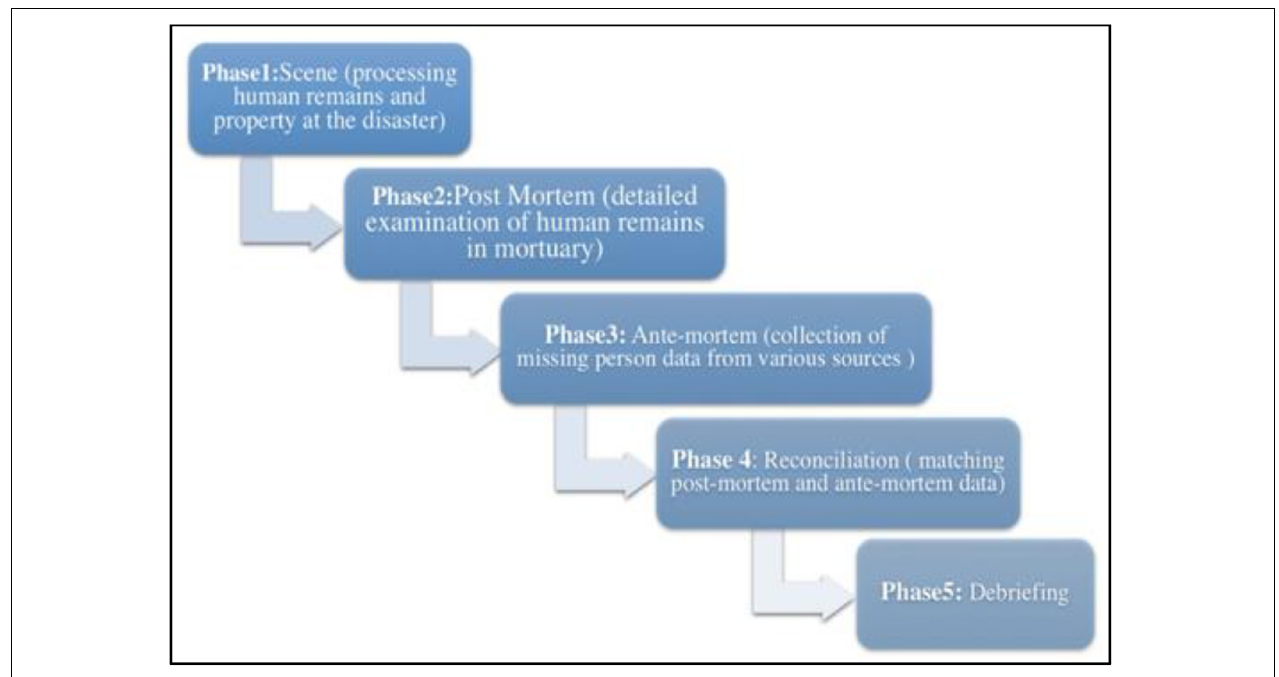
FIGURE 1 | Disaster management and victim identification phases (AlQahtani et al., 2019).